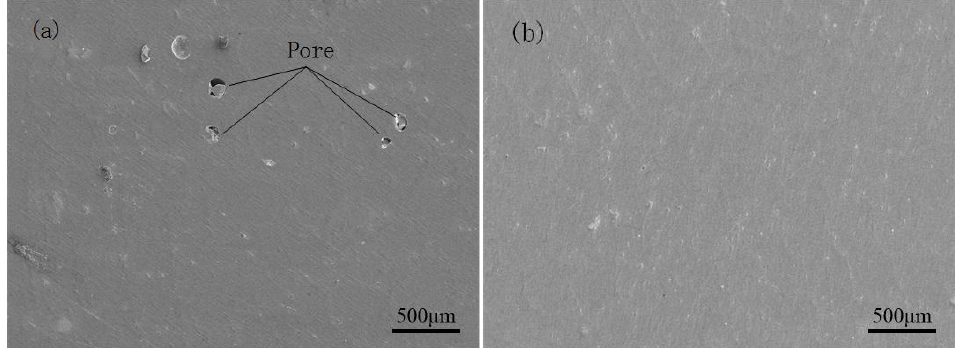
Figure 6. Surface morphology of AlSi10Mg specimens: ( a ) as-fabricated and ( b ) after the UPT.